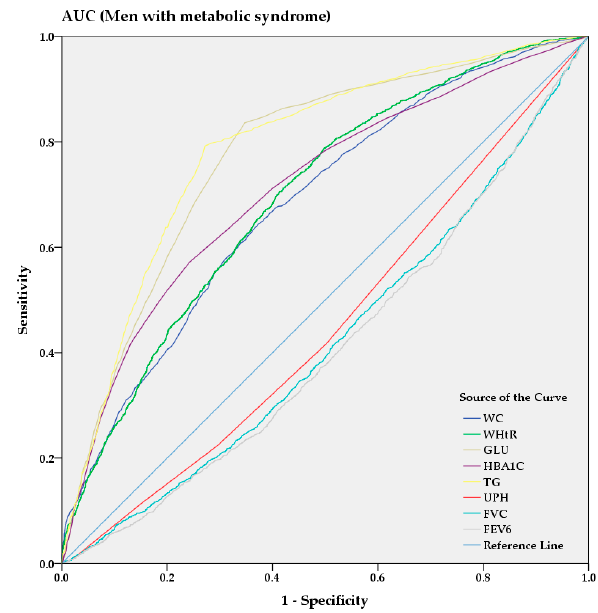
Figure 3. AUC analysis of metabolic syndrome in men.